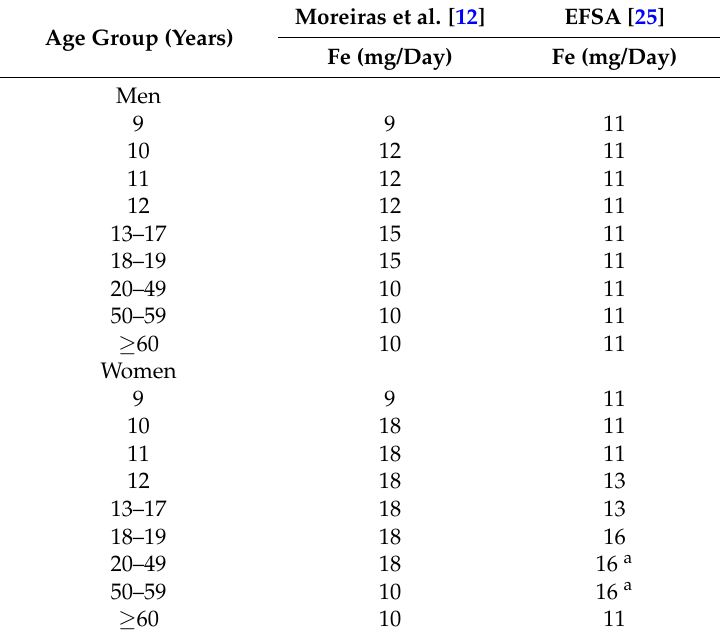
Table 1. Recommended dietary intakes (RDI) by Moreiras and EFSA.